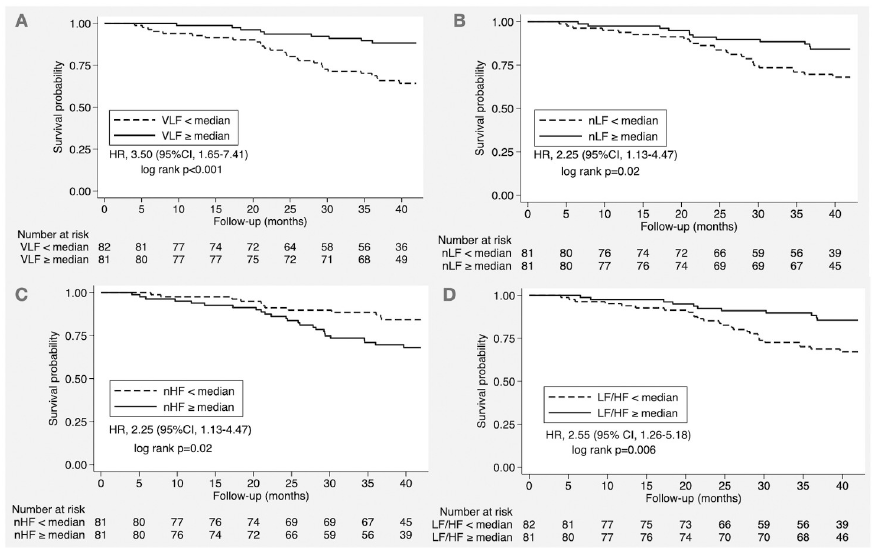
Fig 1. All-cause survival curve according to the post-dialysis HRV parameters. Panel A: VLF, Panel B: nLF, Panel C: nHF and Panel D: LF/HF